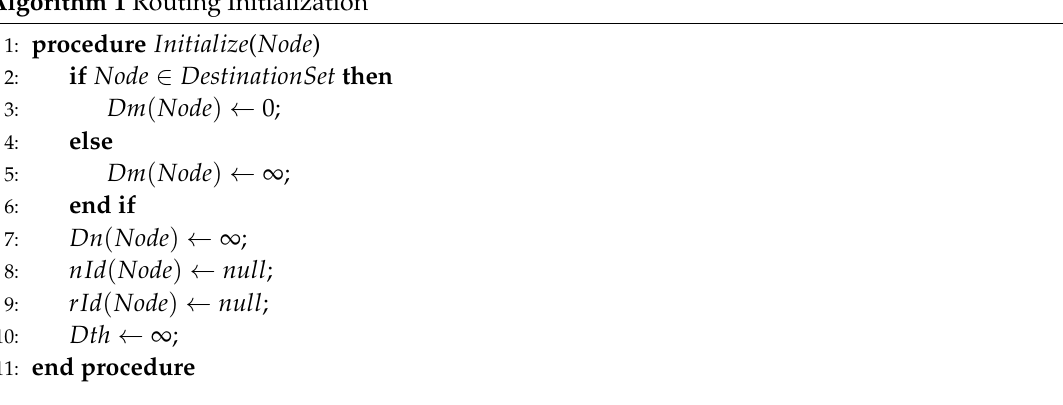
Algorithm 1 Routing